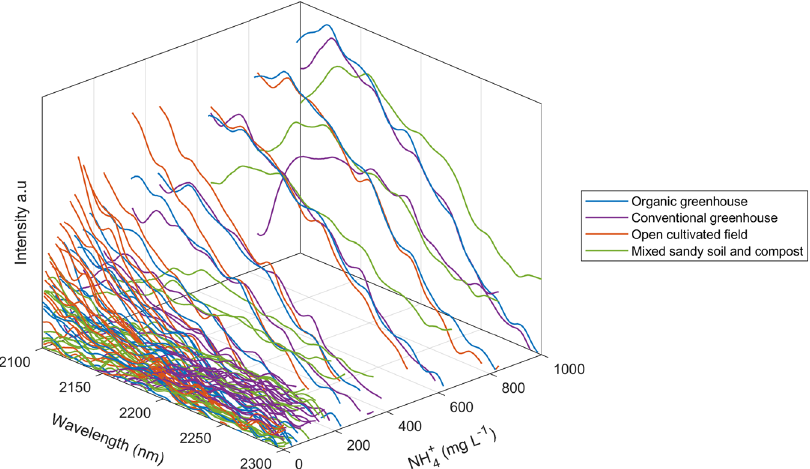
Fig. 2 Spectral data of soil porewater samples used for the training model. Heterogeneous composition of the samples is represented by different spectral signatures at the same